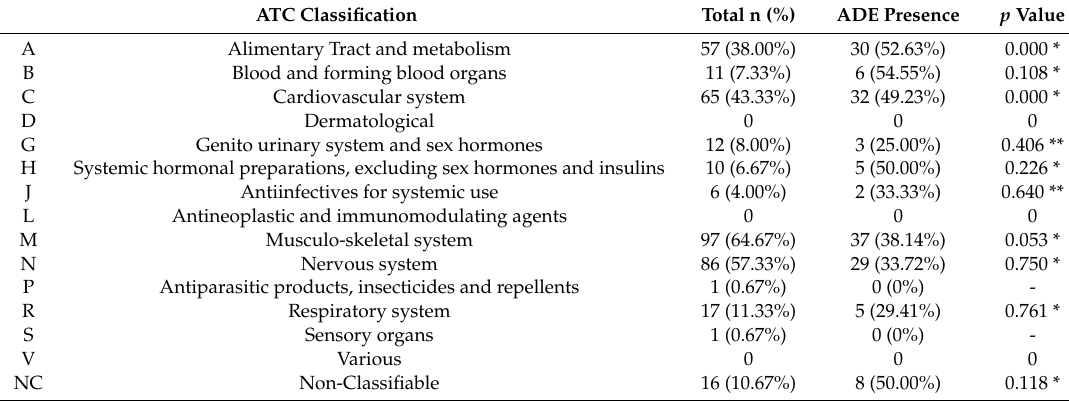
Table 2. Frequency and association of drug groups by ATC classification involved in adverse drug events in adults with severe